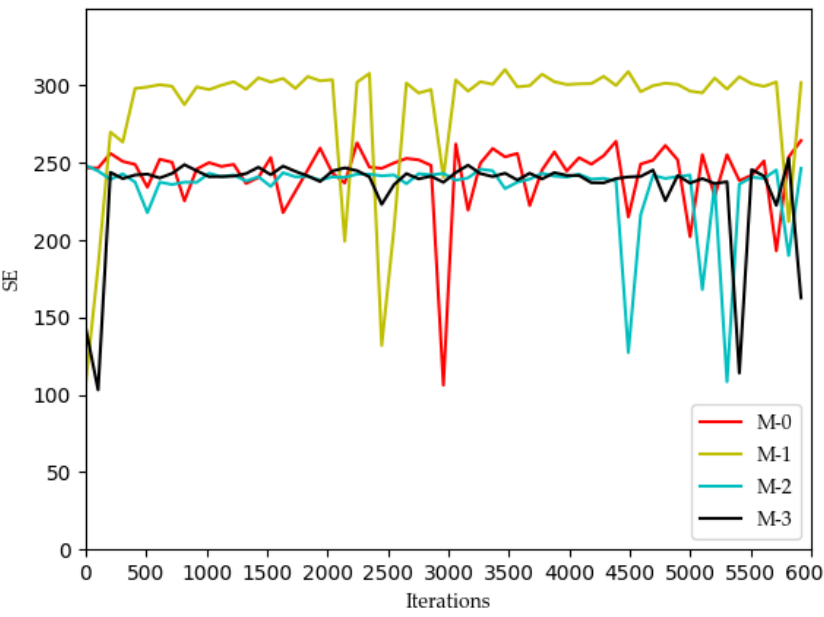
Figure 5. Optimization curve of SE for each MVNO in the lower model based on DQN.